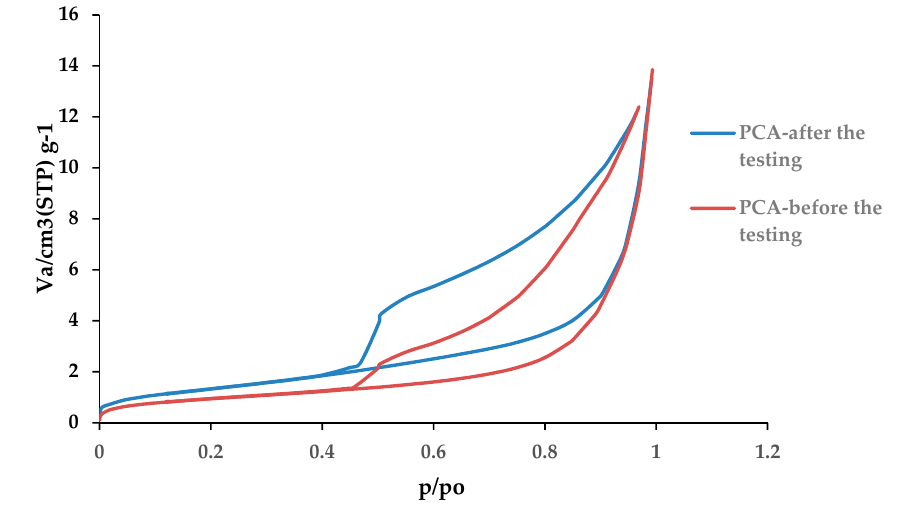
Figure 8. Nitrogen adsorption isotherms for PCA.